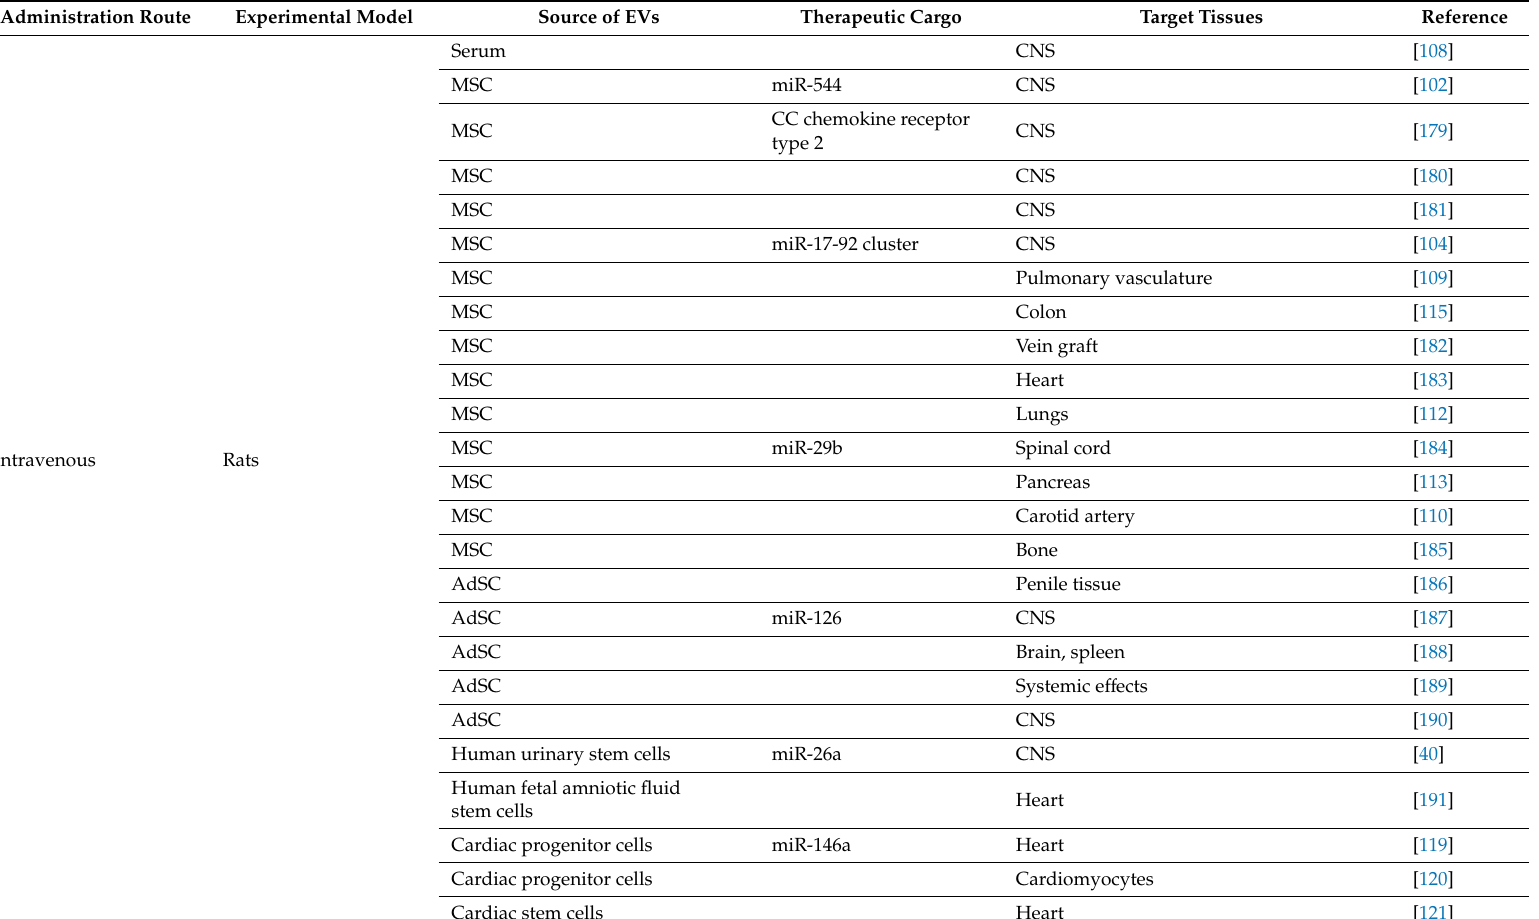
Table 2. Administration routes for EVs in vivo. Detailed are di ff erent studies using in vivo models where EVs were administered. Described are the administration routes, the experimental model, the source of EVs, the therapeutic cargo (when known), and the target tissue of the EVs or the EV-related e ff ects. While in some cases a therapeutic cargo was known, in other cases the EV itself was the therapeutic agent and no particular component of the cargo was specified as responsible for the e ff ect observed. Abbreviations: AdSC: adipose tissue-derived stem cells; CNS: central nervous system; miR: micro RNA; MSC: mesenchymal stem